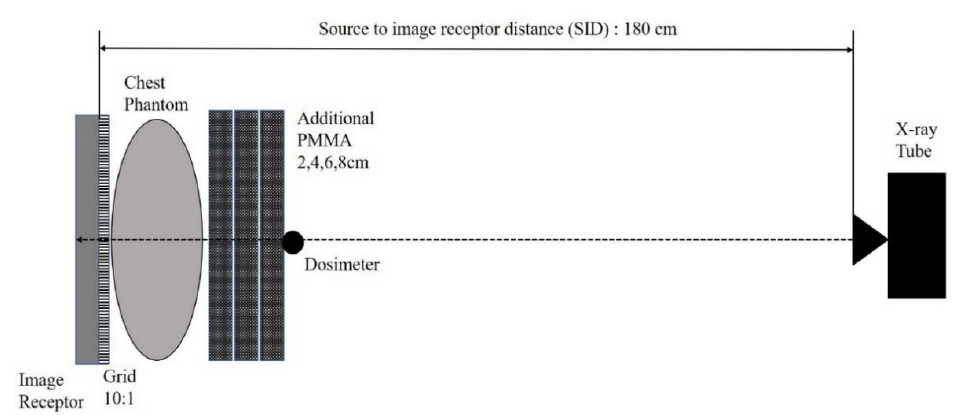
Figure 2. An anthropomorphic chest phantom used in this study.